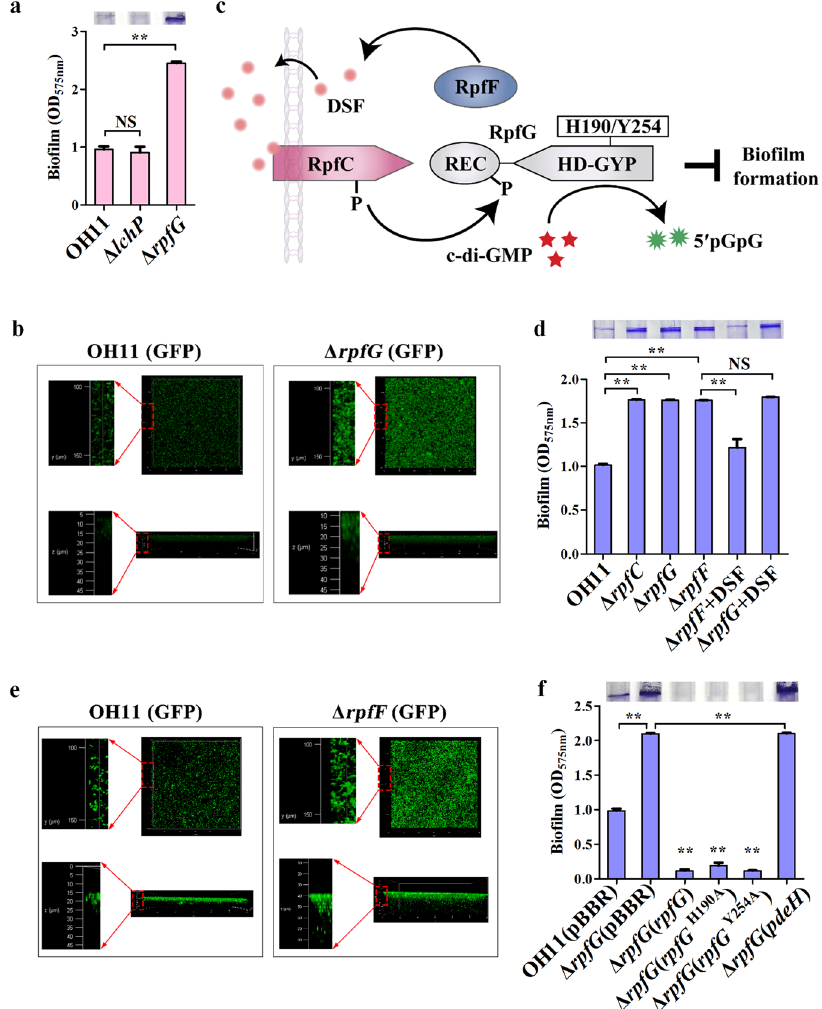
Fig. 3 The DSF system inhibits bio fi lm formation independently of the PDE activity of RpfG in L. enzymogenes. a RpfG, but not LchP, negatively regulates bio fi lm formation. b CLSM of bio fi lm formed by wild-type and rpfG mutants. The upper part of the black box represents top surfaces (y and x axes) of the three-dimensional bio fi lm structures, while the lower part of the black box shows the side surfaces (z and x axes) of the three-dimensional bio fi lm structure. Red circles indicate image magni fi cation. c Schematic showing the DSF system for regulating c-di-GMP production in Xcc . d Effect of all DSF system components on bio fi lm biomass through individual mutations in their respective encoding genes. Δ rpfF + DSF and Δ rpfG + DSF show the effect of adding 10 μ M DSF on bio fi lm formation. e CLSM of bio fi lm formed by wild- type and rpfF mutant. f Involvement of key enzymatically active residues of RpfG in bio fi lm biomass. Δ rpfG ( rpfG ), Δ rpfG ( rpfG H190A ) or Δ rpfG ( rpfG Y254A ) indicates Δ rpfG carrying a plasmid-borne native rpfG or its variants with point mutations. Δ rpfG ( pdeH ) indicates Δ rpfG carrying a plasmid-borne pdeH driven by a constitutive promoter of the vector. Statistical comparisons were performed using one-way ANOVA of GraphPad software (GraphPad, La Jolla, CA). In panels a , d and f , mean data ± SD from three experiments were shown, ** P < 0.01. NS means not signi fi